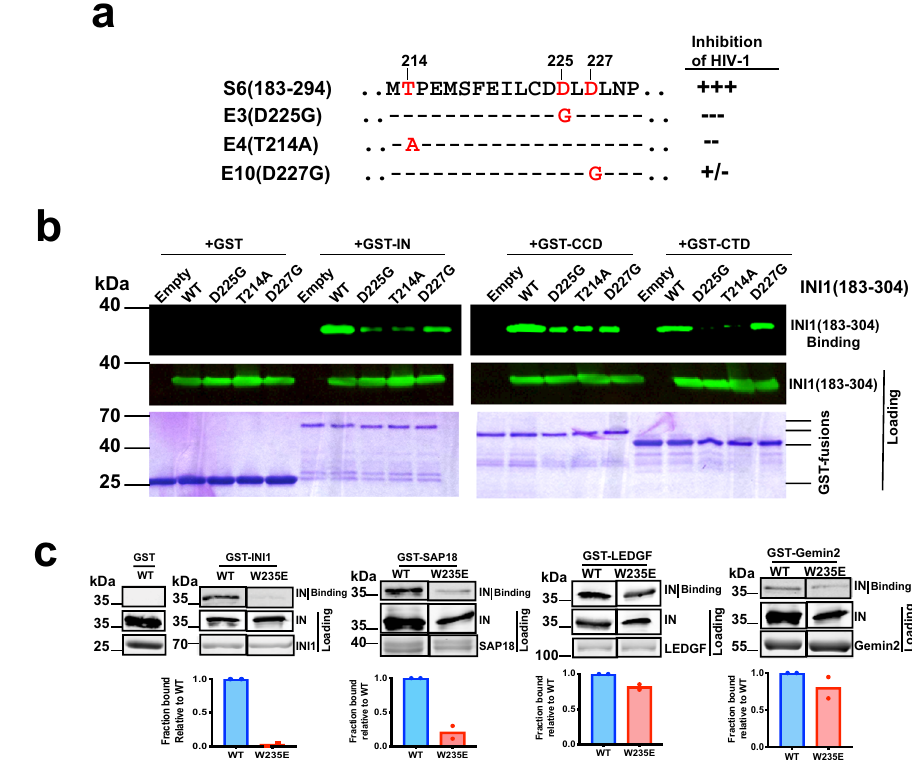
Fig. 3 In vitro binding studies to validate the interacting interface residues predicted in the CTD/INI1 183-304 complex. a Sequence of a portion of S6/ Rpt1 fragment of INI1 and the IN-interaction-defective substitution mutations (E3, E4, and E10) identi fi ed in a random genetic, reverse yeast two-hybrid screen and their effect on S6-mediated inhibition of HIV-1 particle production. b GST-pull down assay to demonstrate the binding of INI1 183-304 and its mutants with IN, CCD and CTD. Representative images from one out of three experiment is shown. Top panel represents bound proteins and the bottom two panels represent the loading control. Top two panels represent the Western blot using α -BAF47 antibodies to detect 6His-SUMO-INI1 183-304 . Bottom panel represents the Coomassie-stained gel of GST-fusion proteins. c GST-pull down assay to determine the interaction of His 6 -IN(WT), His 6 -IN(W235E) mutant with GST-INI1, GST-SAP18, GST-LEDGF, and GST-Gemin2. Representative images from one out of three experiment is shown. Top panel represents the bound proteins and the two panels below the top represent the loading controls. Non-adjacent lanes from the same gel are spliced together for the fi gure and uncropped gels are provided in the source data. Graphs at the bottom represent quantitation of the bound proteins expressed as fraction bound after normalizing to the loading control. The graphs represent the mean of two independent experiments, WT is Wild type IN (shown in blue) and W235E is shown in